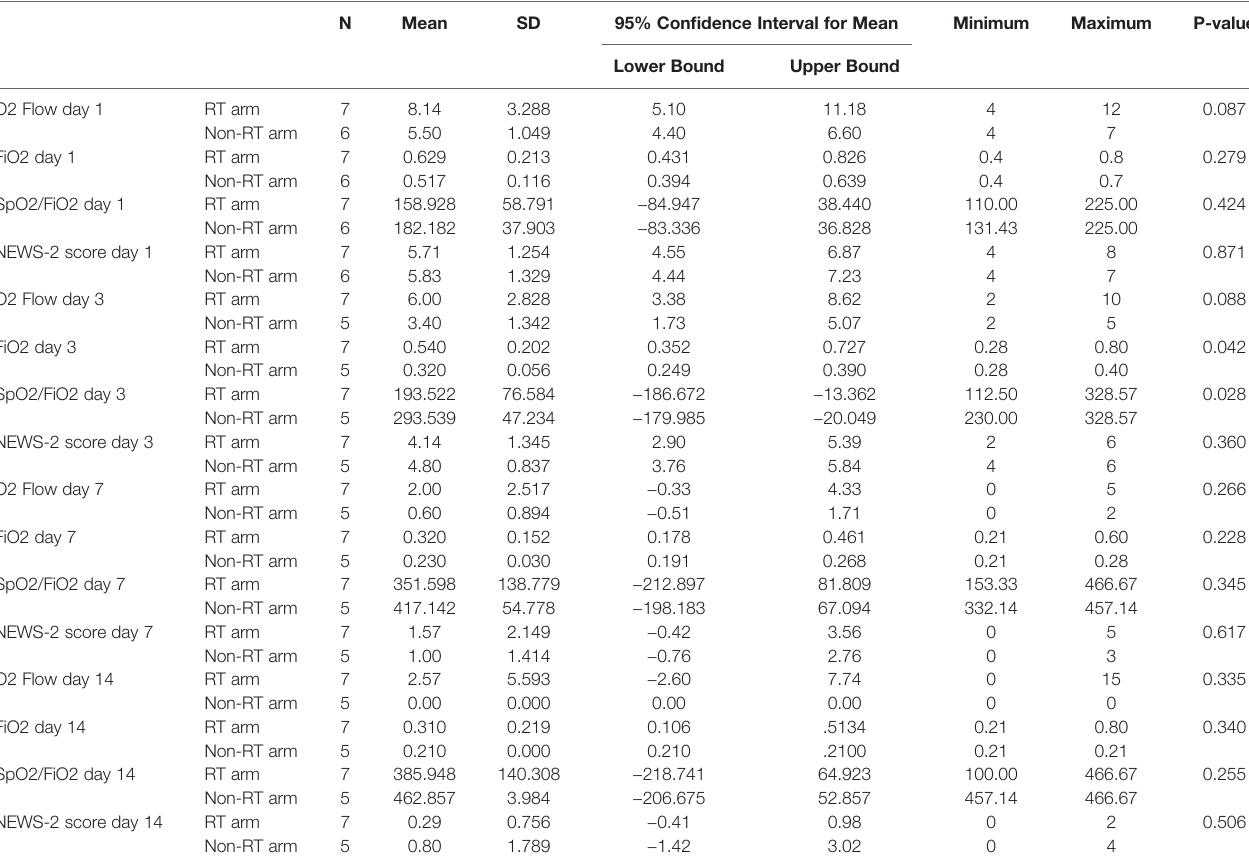
TABLE 4 | Oxygen parameters and NEWS-2 score on the day of LDRT and serial follow up. N Mean SD 95% Con fi dence Interval for